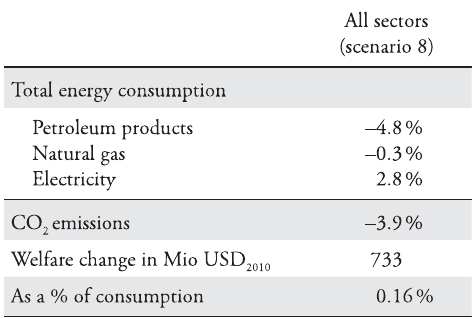
Table 6: Impacts of Climate Change Induced Variations in both